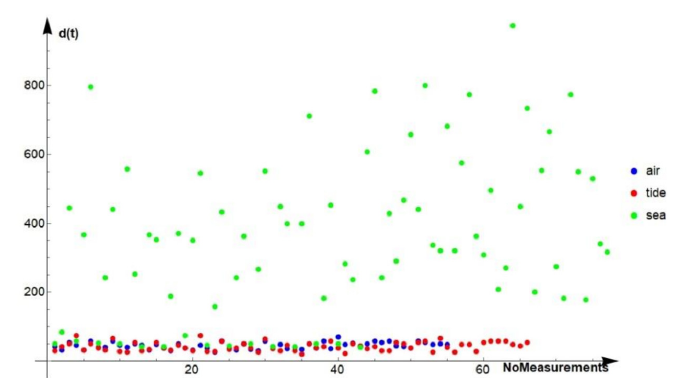
Figure 5. Display of raw data for the NiTi-1 alloy.